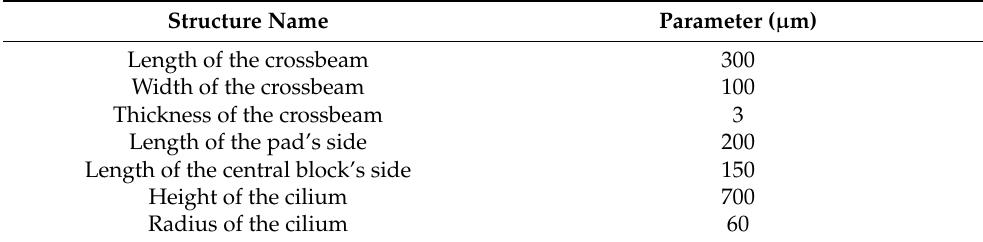
Table 2. Values of structure parameters.